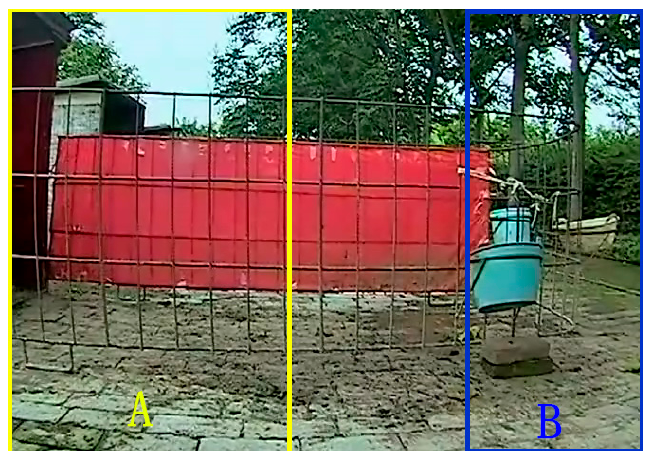
Figure 4. Calf scene-interactive behavior detection area. Calf’s behaviors of entering and leaving resting area were detected in Area A (yellow box: horizontal distance is body length of calf; resting area located on left of A zone). Feeding and drinking behaviors were detected in Area B (blue box: left border is left border of feeding-basin).